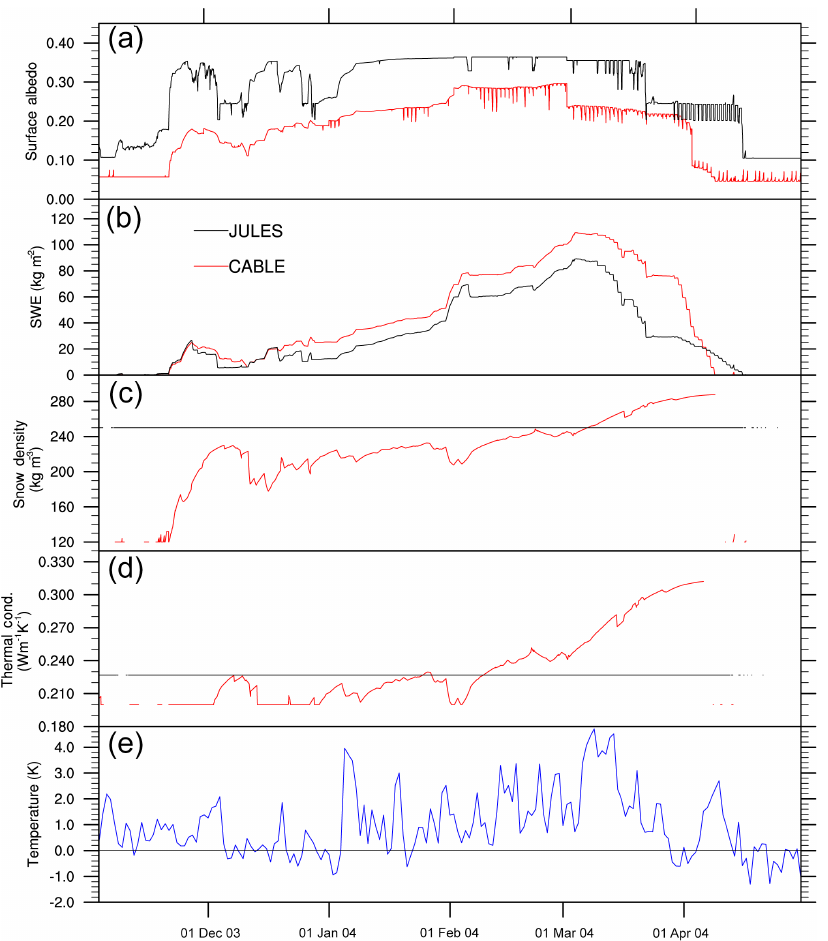
Figure 10. Offline simulation of 2003/2004 winter snow processes in Hyytiälä for CABLE (red) and JULES (black); (a) surface albedo, (b) snow water equivalent (SWE) in kgm − 2 , (c) snow density in kgm − 3 , (d) thermal conductivity in Wm − 1 K − 1 , and (e) the mean daily surface temperature difference, CABLE minus JULES, in